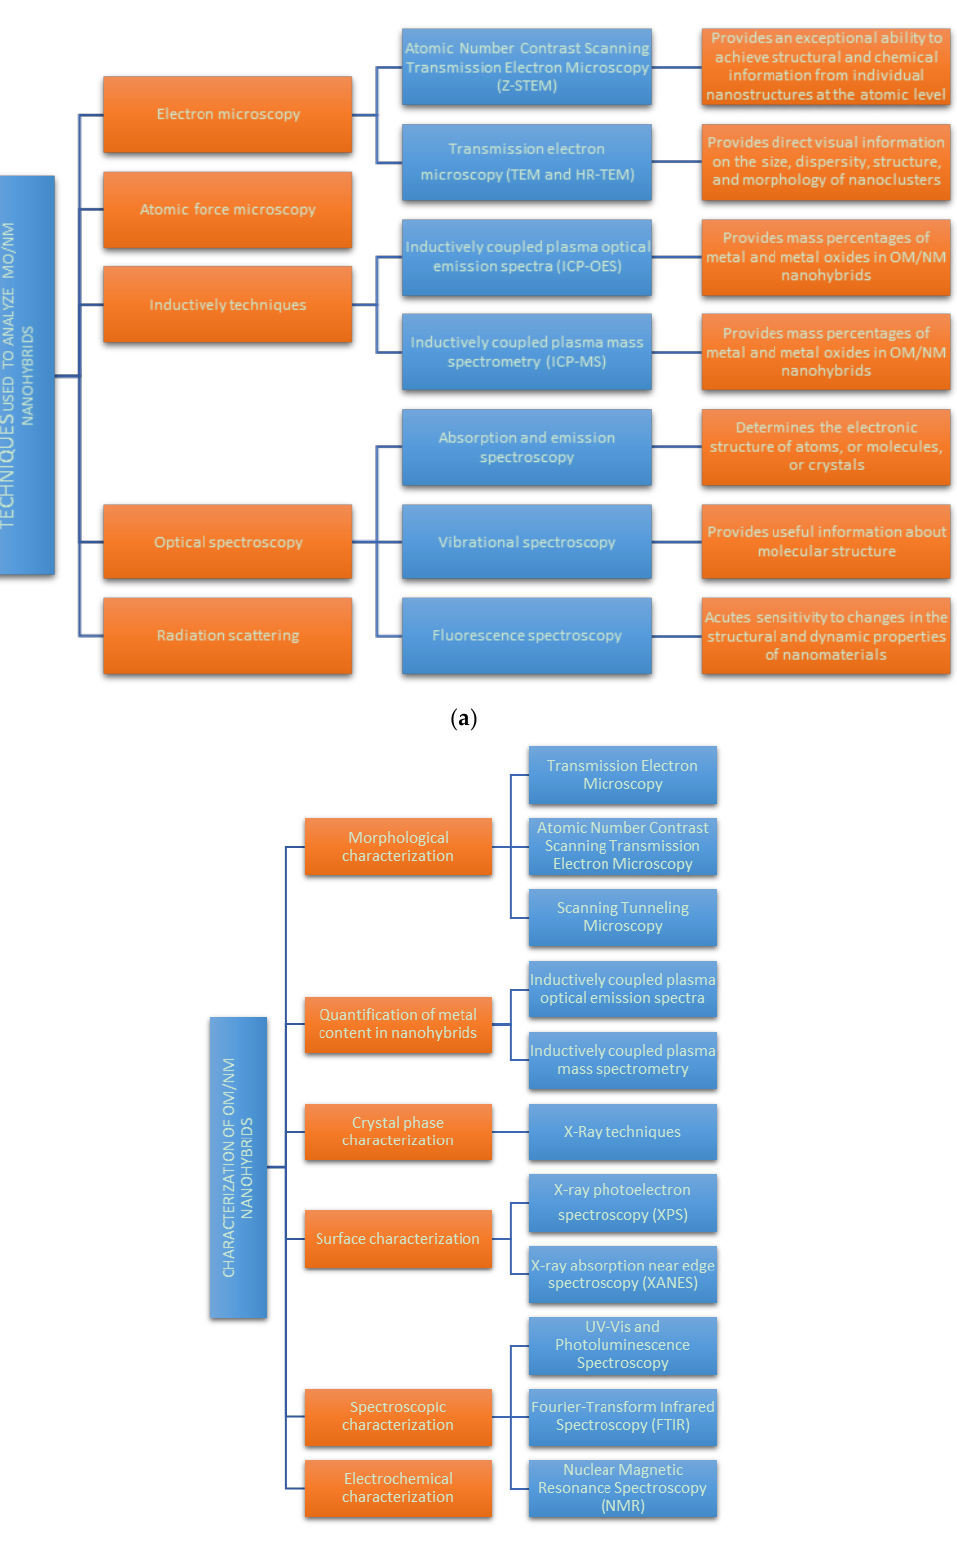
Figure 7. (a) Relevant techniques used to characterize MO/noble metal nanohybrids (classified as Figure 7. ( a ) Relevant techniques used to characterize MO / noble metal nanohybrids (classified as families of techniques). ( b ) Characterization techniques of MO/noble metal hybrid nanoparticles families of techniques). ( b ) Characterization techniques of MO / noble metal hybrid nanoparticles (classified by characterization type). (classified by characterization